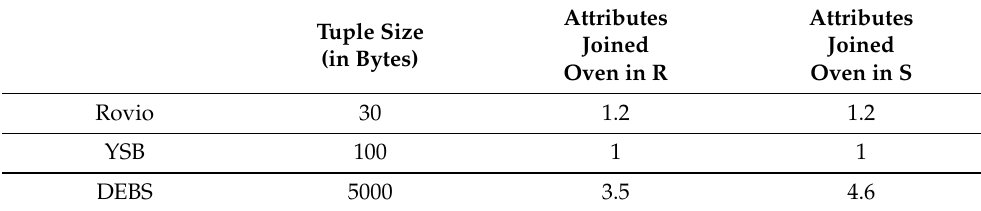
Table 3. Join attribute and size of tuple per